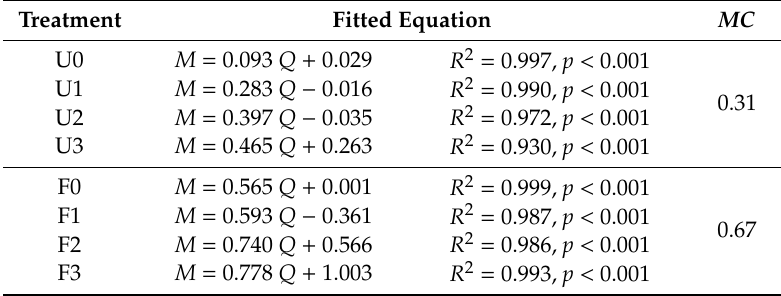
Table 3. Cumulative runo ff and cumulative sediment yield fitted